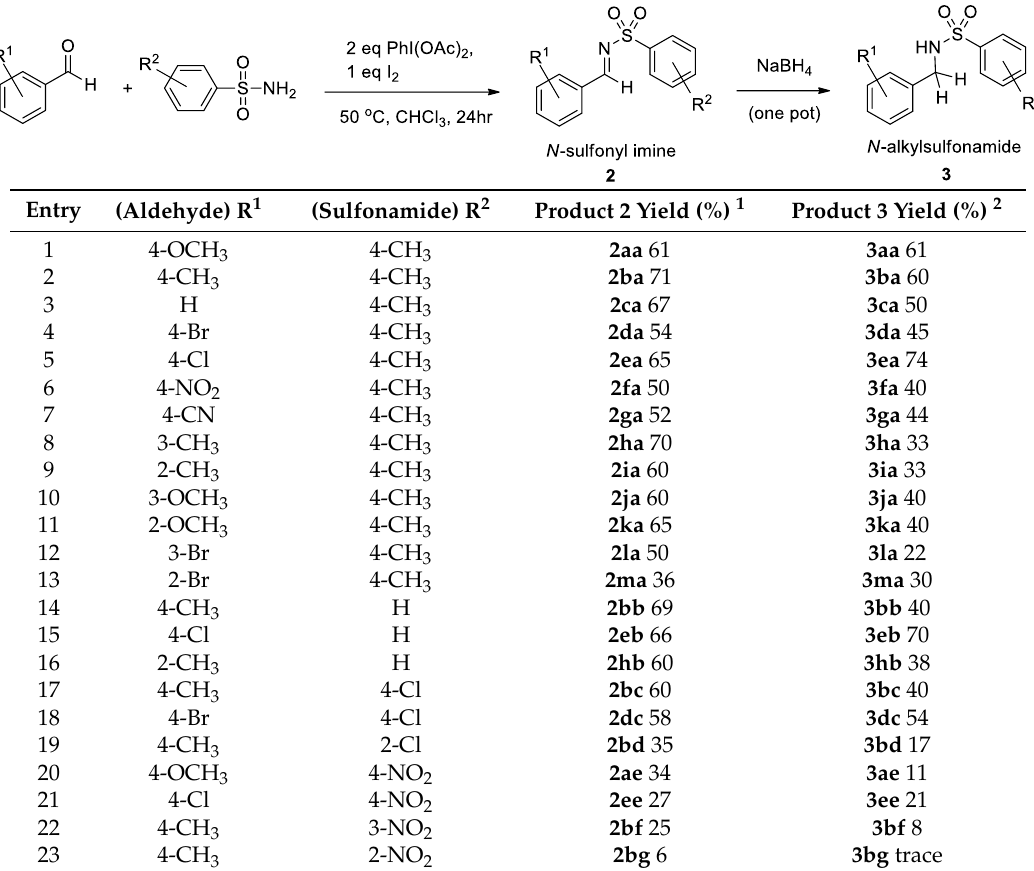
Table 4. Substrate scope of N -sulfonyl imine 2 and N -alkylsulfonamide 3 Table 4 . Substrate scope of N -sulfonyl imine 2 and N -alkylsulfonamide 3 formation.